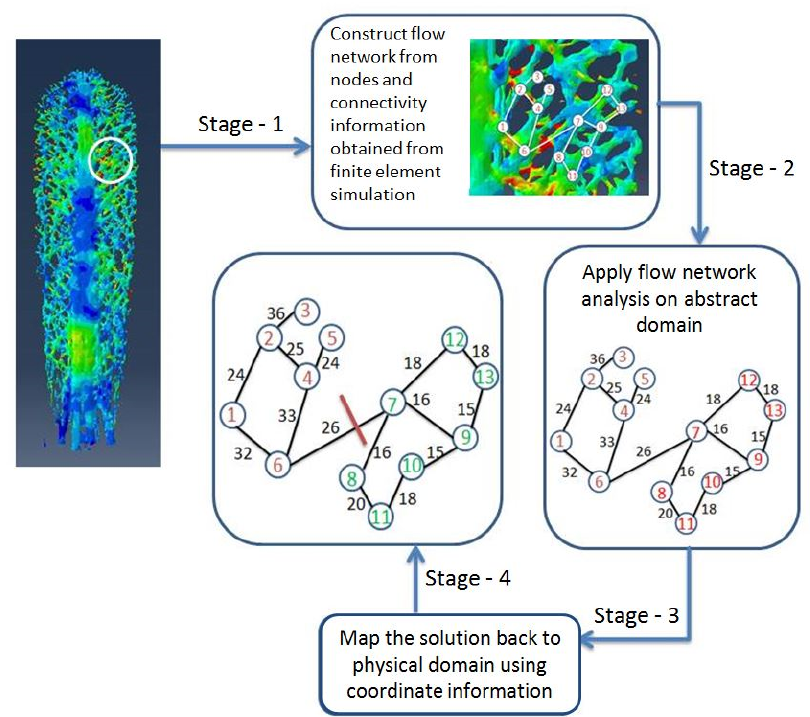
Figure 4. Flowchart depicting the steps involved in formulating a small part of rostrum as a network flow problem.